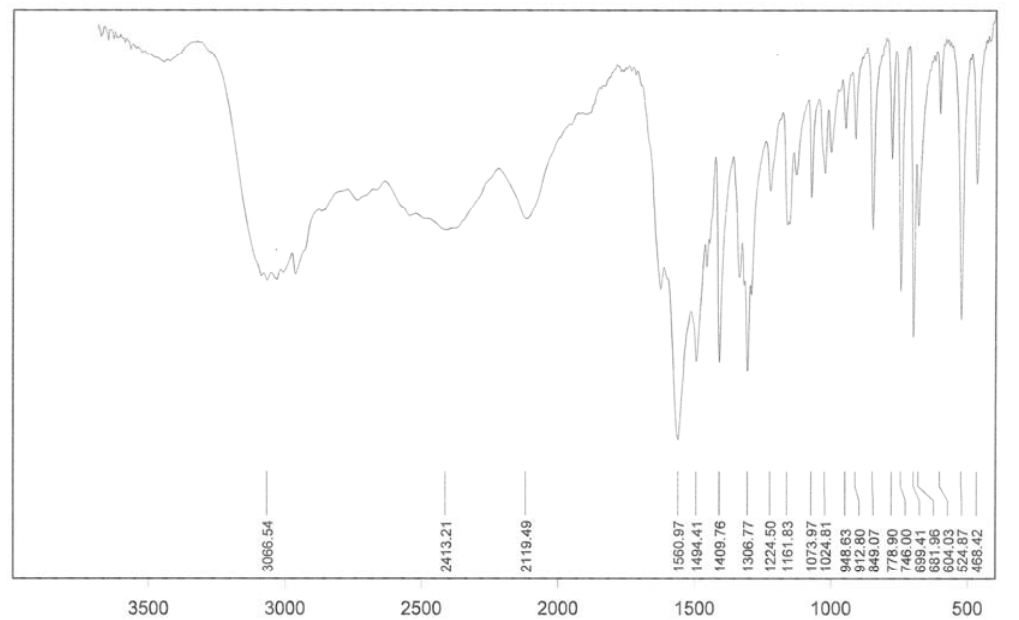
Figure 1. IR spectrum of